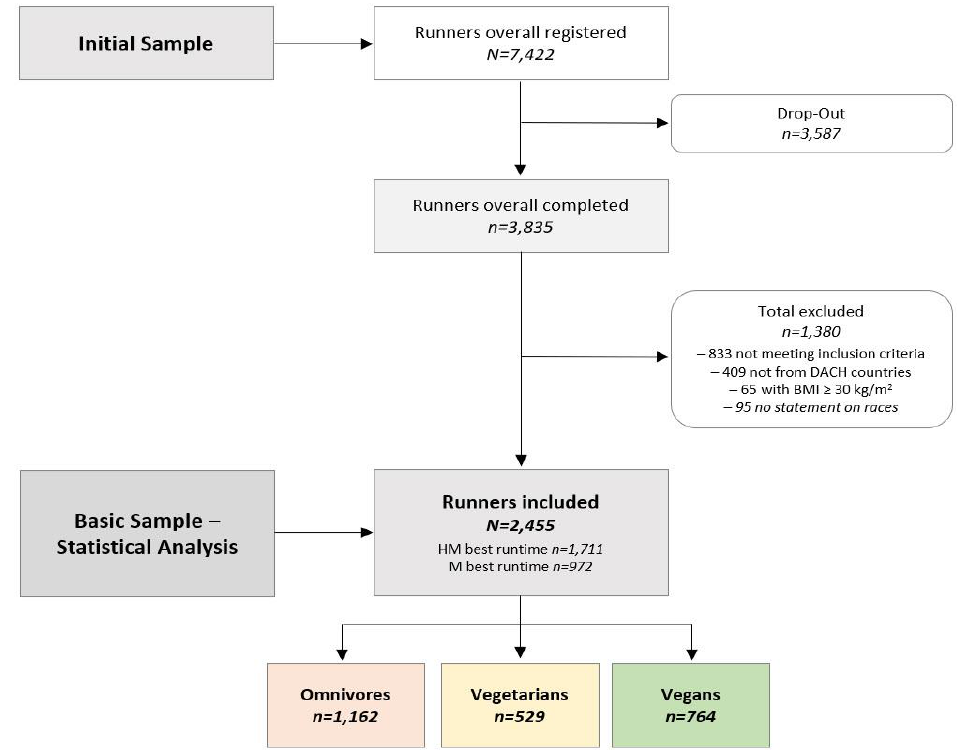
Figure 1. Flow of participants’ enrollment and dietary subgroups. BMI, body mass index; D-A-CH, Germany, Austria, and Switzerland; Omnivores, those who have no restriction on source of food; Vegetarians, those who avoid all flesh foods but consume egg and/or dairy products; Vegans, those who avoid all foods and ingredients from animal sources.